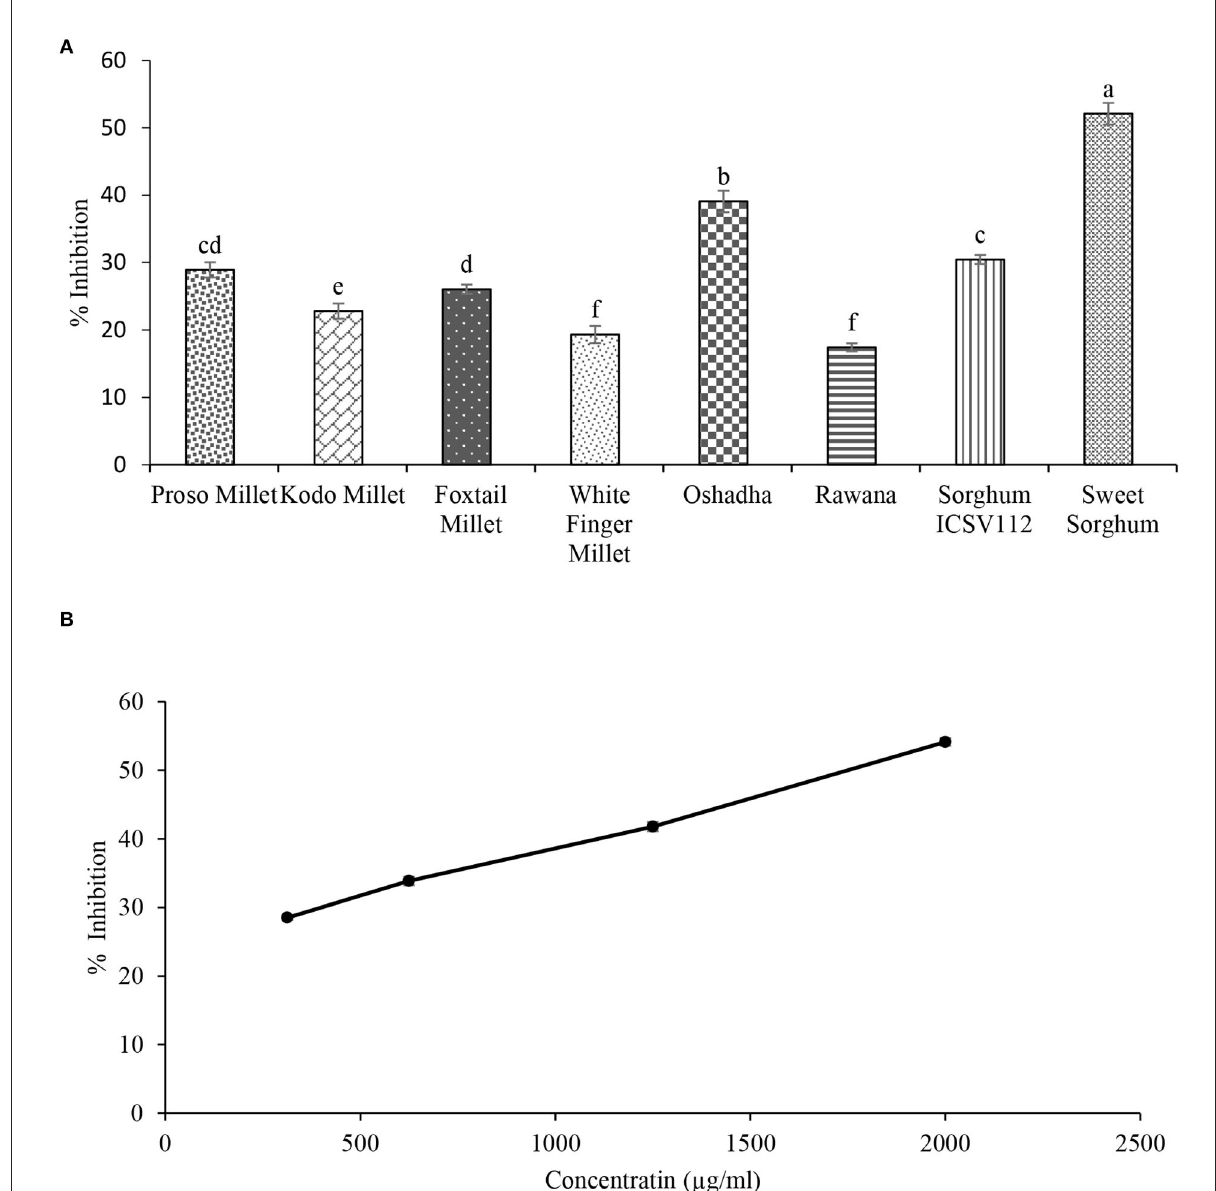
FIGURE3 Cholesterol esterase inhibitory activity of selected samples. (A) Screening of selected millet types and sorghum varieties for cholesterol esterase inhibitory activity at 2 mg/ml concentration. (B) Dose-response relationship of sweet sorghum for cholesterol esterase inhibitory activity: IC 50 : 1861.71 ± 20.74 µ g/ml. Different letters on bar graphs are significantly different at P <